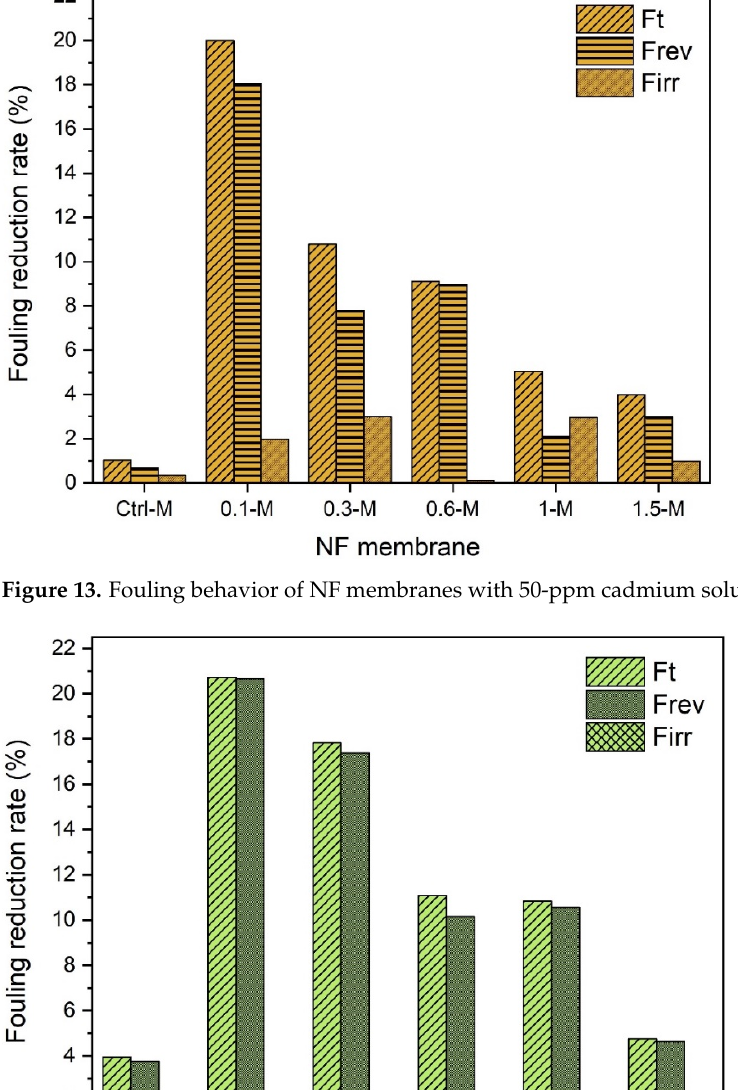
Figure 14. Fouling behavior of NF membranes with 50-ppm lead solution.